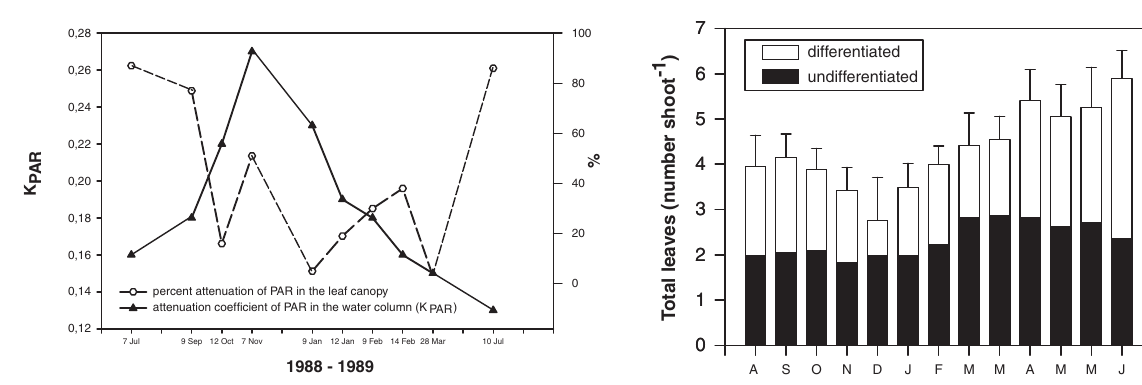
F IG . 2. – The annual trends of the attenuation of coefficient PAR in the water column and of the percent attenuation of PAR in the leaf F IG . 4. – Annual pattern of the mean leaf number per shoot of C. canopy. nodosa, in the different ranks (standard deviations are related to the total mean number of the leaves in the